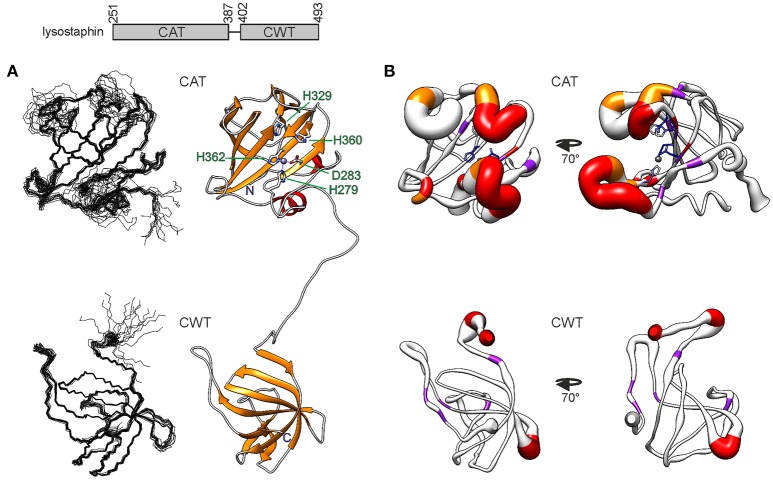
Structure of S. simulans lysostaphin. On top, the domain structure is depicted. The N-terminal CAT domain is composed of 137 residues and the C-terminal CWT domain of 92 residues. The domains are linked by a flexible 14-residue linker. (A) Solution NMR structure of lysostaphin. On the left, the two domains are represented as ensembles of 15 superimposed structures. On the right, a representative member of the ensemble is shown in a ribbon diagram. The catalytic site residues in the CAT domain are labeled. Zinc is shown as a gray sphere. (B) CAT (top) and CWT domain dynamics. The heavy atom RMSF obtained from the MD simulation is depicted as the radius of the ribbon. Residues which lack or display strongly attenuated amide peak in the 1H, 15N HSQC spectrum are colored in red and orange, respectively. Residues which experience μs-ms dynamics are colored in purple. Catalytic site residues in the CAT domain are colored according to their heavy atom RMSF, blue depicting low RMSF values and lighter colors higher RMSF values. The structure on the left has the same orientation as the structures in (A), whereas the structure on the right has been rotated 70 degrees around the vertical axis.